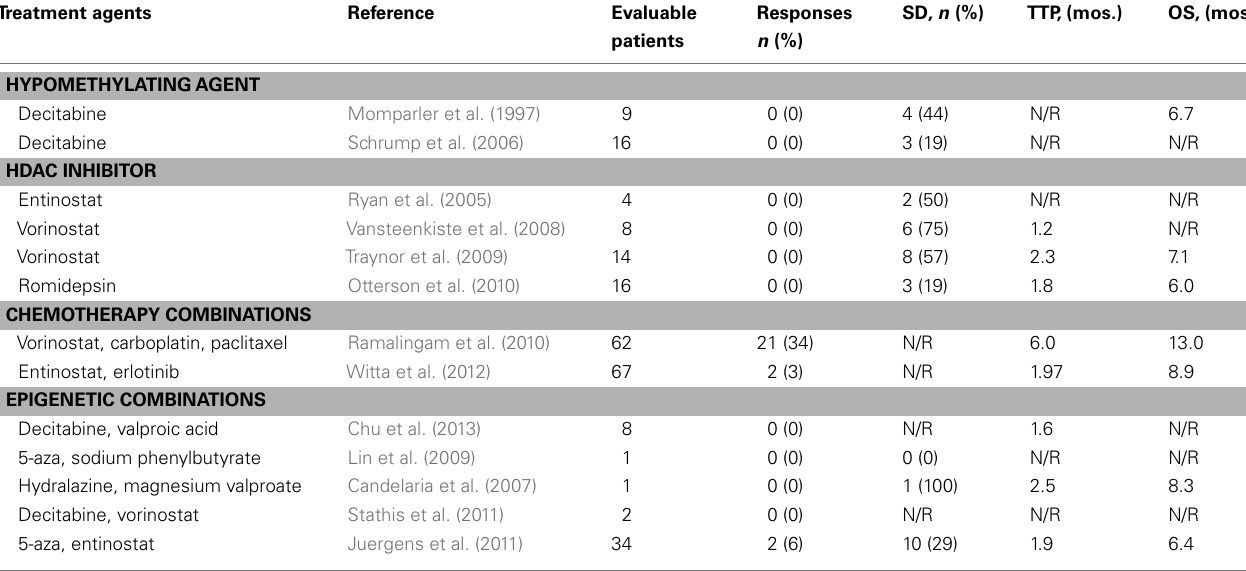
Table 1 | Summary of selected epigenetic clinical trials in lung